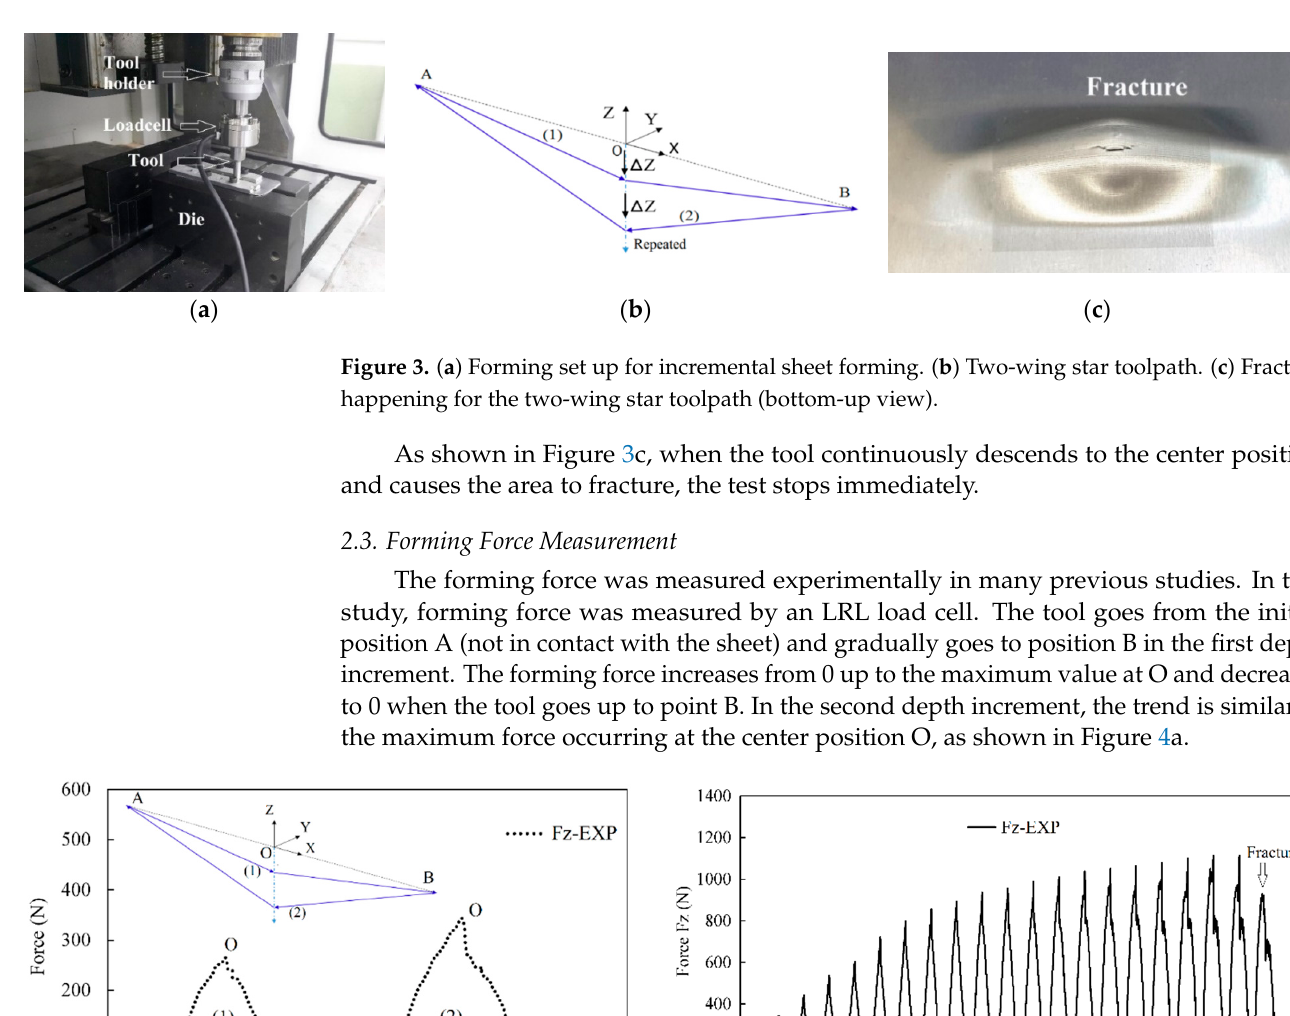
Figure 3. ( a ) Forming set up for incremental sheet forming. ( b ) Two-wing star toolpath. ( c ) Fracture happening for the two-wing star toolpath (bottom-up view).